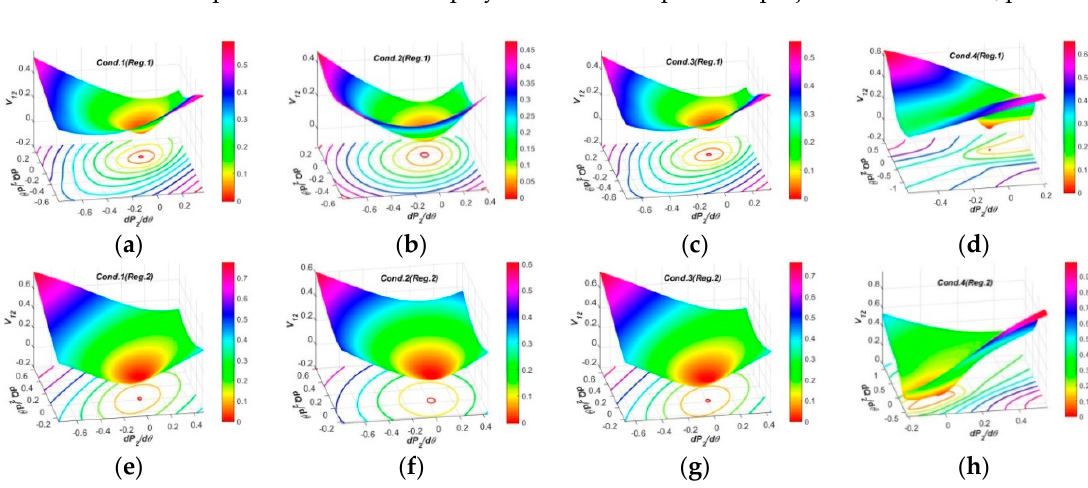
Figure 9. Spatial surfaces of PFG to CIV2 at SCP3 in spaces: ( a – d ) Spatial surfaces of PFG to CIV2 by Reg.1 of OSIV in four operation conditions; ( e – h ) Spatial surfaces of PFG to CIV2 by Reg.2 of OSIV in four operation